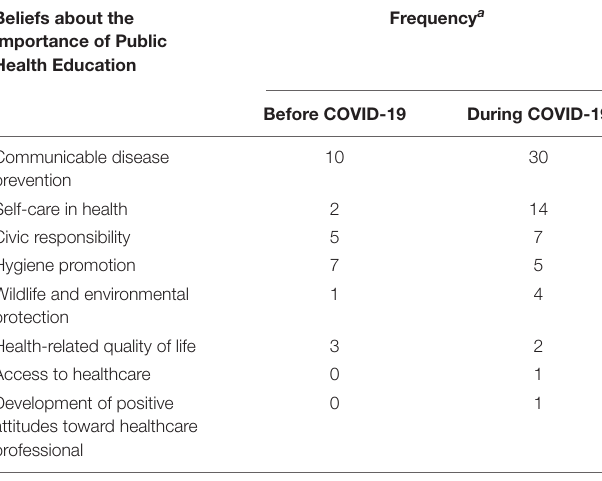
TABLE 3 | Comparison of pre-service teachers’ beliefs about the importance of public health education before and during the COVID-19